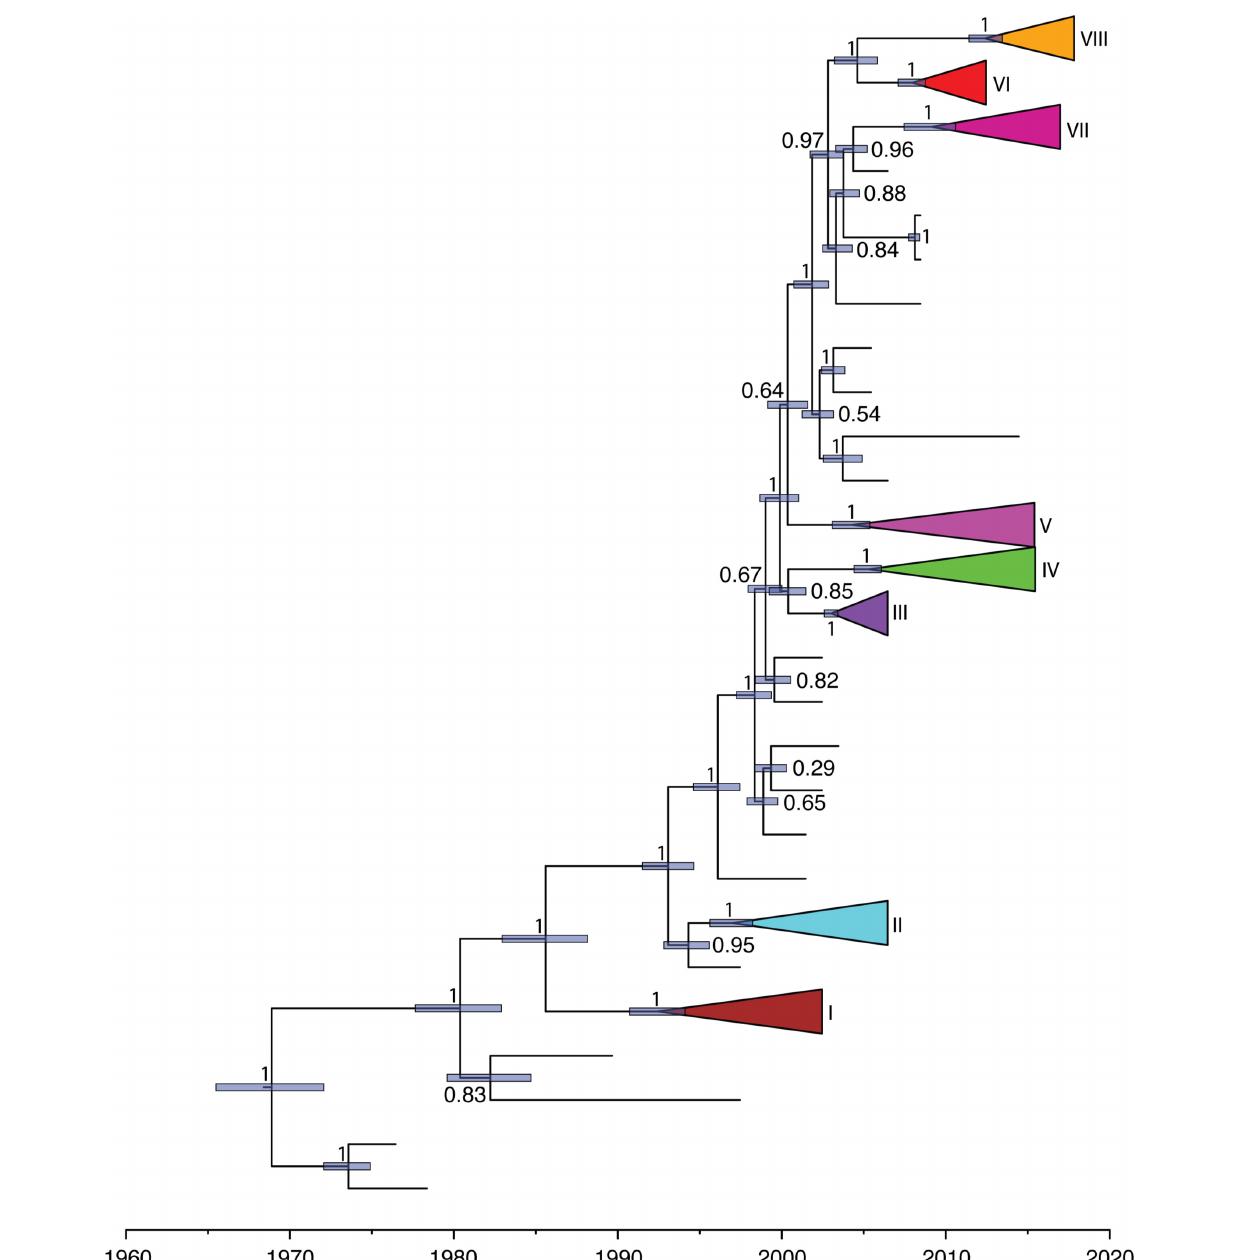
Frontiers in Microbiology |